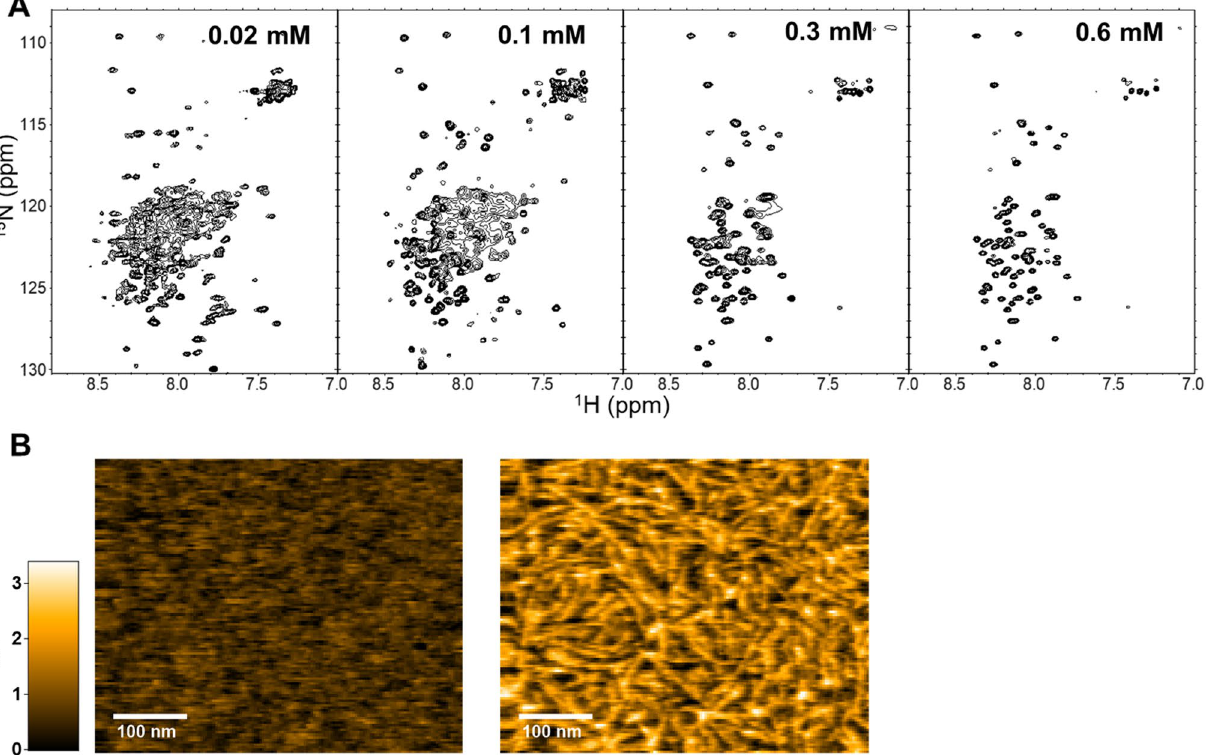
Figure 2. Fibril formation of the CAHS1 protein in vitro. ( A ) 1 H- 15 N HSQC spectra of the CAHS1 protein at protein concentrations of 0.02, 0.1, 0.3, and 0.6 mM. ( B ) Typical HS-AFM images of CAHS1 protein fibrils. Left: the HS-AFM image of the mica surface with CAHS1 protein at a final concentration of 0.4 μM, about 3 min after injection into the observation solution. Right: the HS-AFM image about 2 min after the addition of CAHS1 protein at a final concentration of 3.3